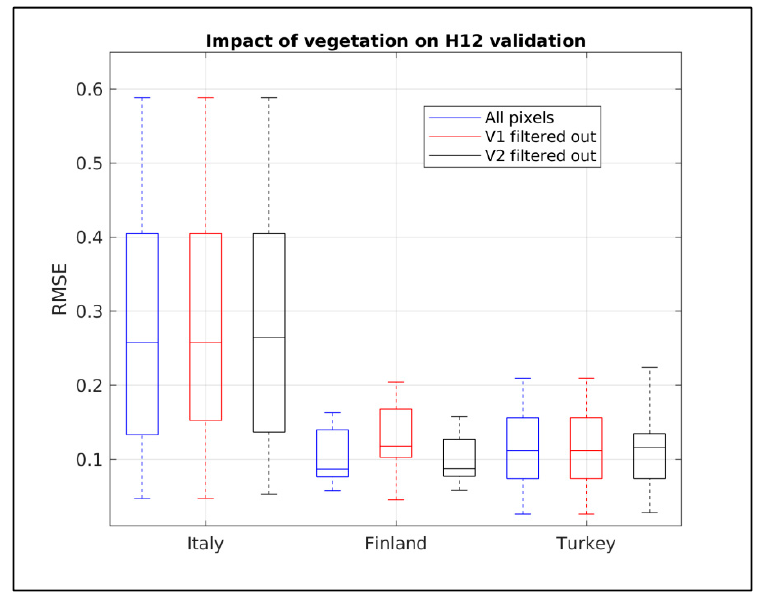
Figure 19. Impact of vegetation types on the comparison procedure of H12 product.